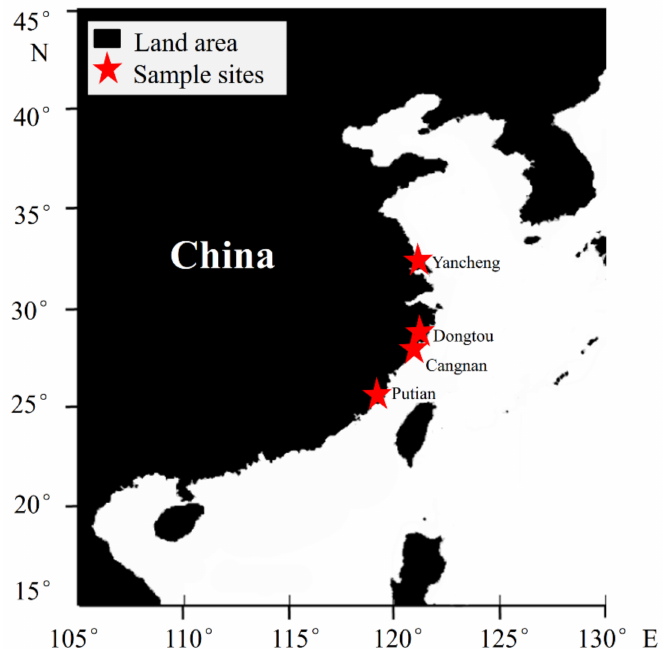
Figure 9. The sampling sites of P. haitanensis . The thallus was collected from Putian (25 ◦ 28 (cid:48) N, 119 ◦ 02 (cid:48) E), Dongtou (27 ◦ 51 (cid:48) N, 121 ◦ 08 (cid:48) E), Cangnan (27 ◦ 30 (cid:48) N, 120 ◦ 24 (cid:48) E), and Yancheng (33 ◦ 24 (cid:48) N, 120 ◦ 09 (cid:48)